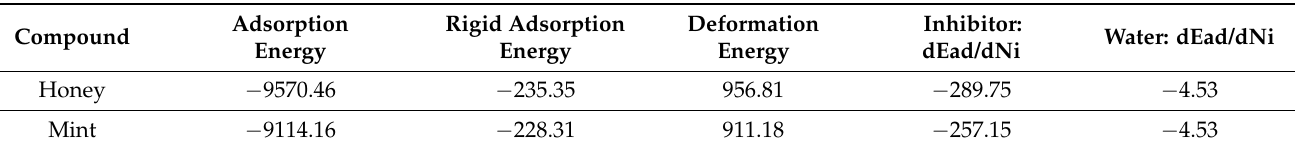
Table 4. Calculated values of (%IE) and (θ) by using the Weight Loss method for aluminum in the aqueous solution of inhibitor and 1 M HCl (duration is 2 h). The standard deviation is shown by the (±) sign, and these numbers represent the average of three measurements.